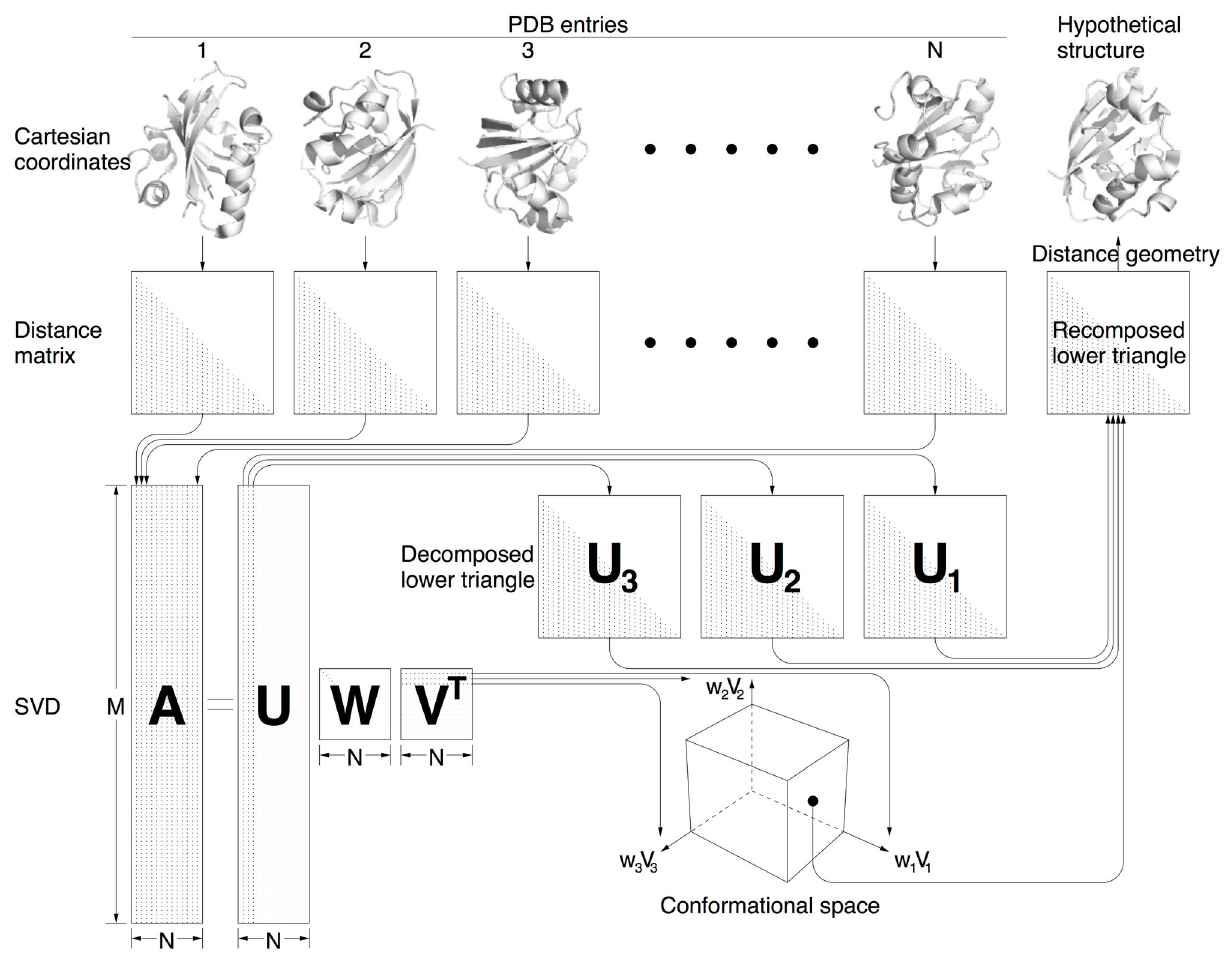
Figure 1. A flowchart of meta-analysis loop. Distance matrices are calculated from N related PDB entries in form of Cartesian coordinates. The lower triangles of the distance matrices are assembled into columns of matrix A . The first a few significant left singular vectors in U resulting from SVD are reconstructed to form decomposed lower triangles. The corresponding singular values and right singular vectors are presented in a multidimensional conformational space. Any given location in this space leads to a recomposed lower triangle by a linear combination of the significant lower triangles. Finally, a hypothetical structure is determined by distance geometry using all constraints in the recomposed lower